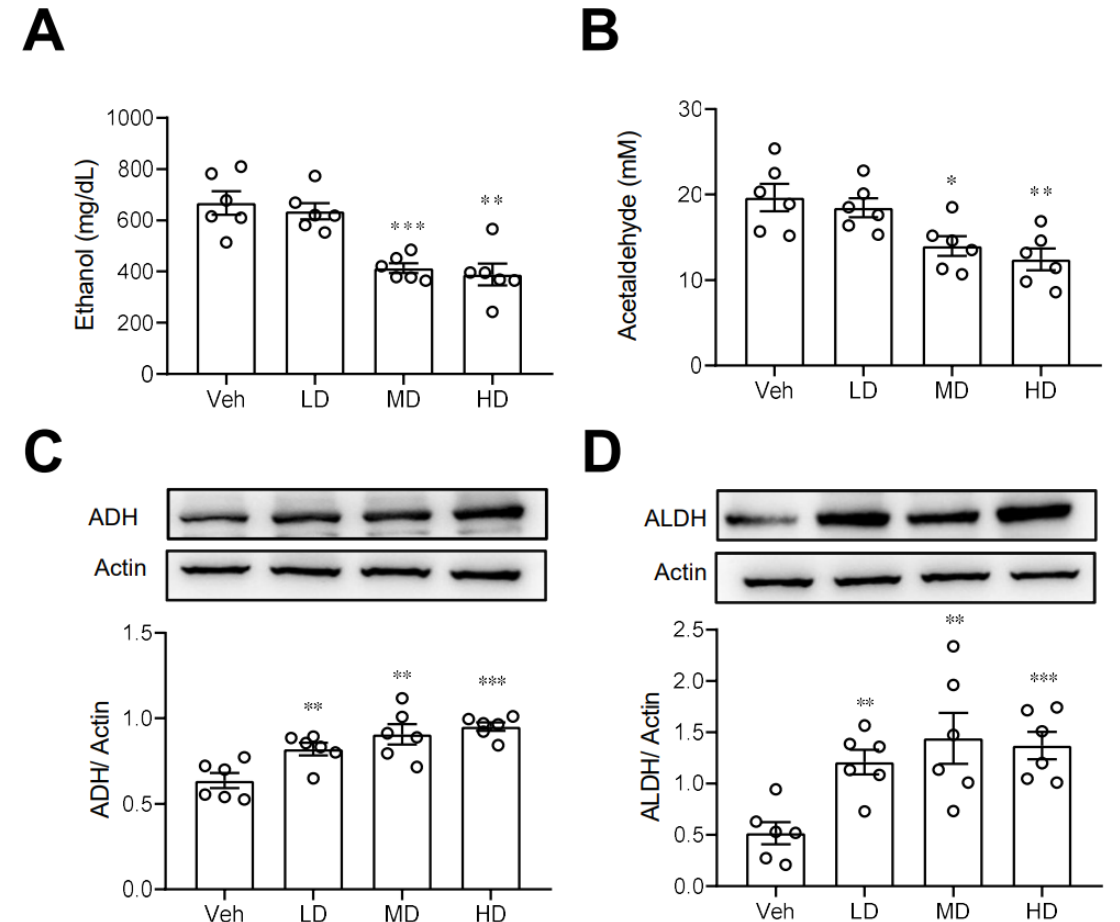
Figure 3. Ethanol catabolism is enhanced by coral hydrate in mice. Coral hydrate was administered to mice via oral gavage for 7 days before the intraperitoneal injection of ethanol. Each group of the mice were fasted overnight prior to ethanol injection. Blood samples were collected for the determination of plasma ethanol ( A ) and acetaldehyde ( B ) concentrations using a commercially available kit. Two hours after the injection of ethanol, experimental animals of each group were sacrificed, and liver tissues were removed for measurements of alcohol dehydrogenase (ADH) ( C ), and acetaldehyde dehydrogenase (ALDH) ( D ) by Western blot. Low-dose group (LD), 105 mg/kg coral hydrate; Medium-dose group (MD), 210 mg/kg coral hydrate; High-dose group (HD), 420 mg/kg coral hydrate; vehicle group (Veh), 420 mg/ kg coral calcium dissolved in 3% carboxymethyl cellulose. N = 6 mice for each group; * p < 0.05; ** p < 0.01; *** p < 0.001 as compared with vehicle group.